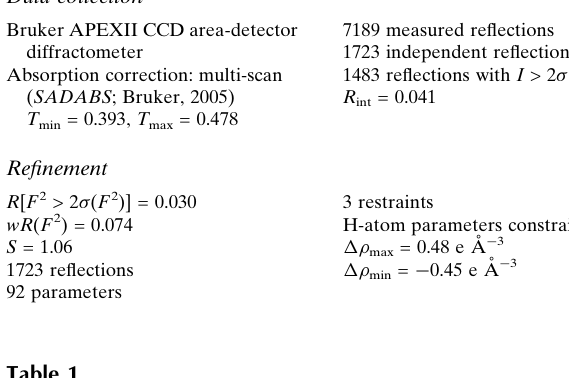
Hydrogen-bond geometry (A˚ , (cid:3)